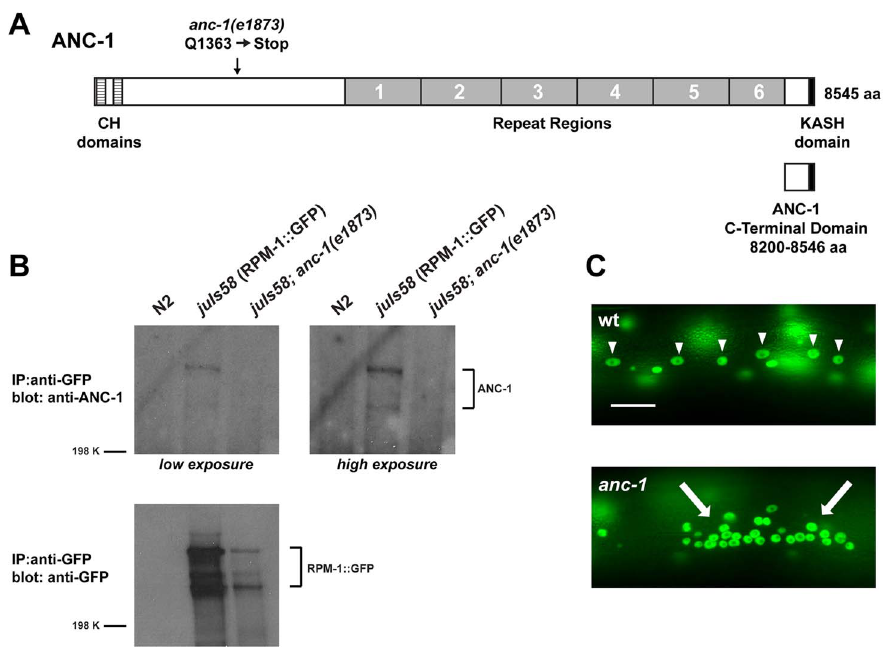
Figure 1. ANC-1 binds to RPM-1. (A) Schematic of ANC-1 protein structure which consists of two calponin homology (CH) domains that bind F- actin (dashed boxes), 6 repeat regions (grey), and a KASH domain (black) that mediates binding to the nucleus. Also shown is the C-terminal domain of ANC-1 that functions as a dominant negative. (B) CoIP of endogenous ANC-1 with RPM-1::GFP. CoIPs were performed from whole worm lysates prepared from transgenic animals ( juIs58 ) or non-transgenic animals (N2). (C) Epifluorescent microscopy was used to visualize SUR-5::GFP in the multinucleated hypodermal cells of C. elegans . In wild-type animals, nuclei are anchored to the actin cytoskeleton and evenly spaced throughout the syncytium (arrowheads). In anc-1 mutants, impaired nuclear anchorage leads to aggregation of nuclei (arrows). Scale bar is 20 m m.